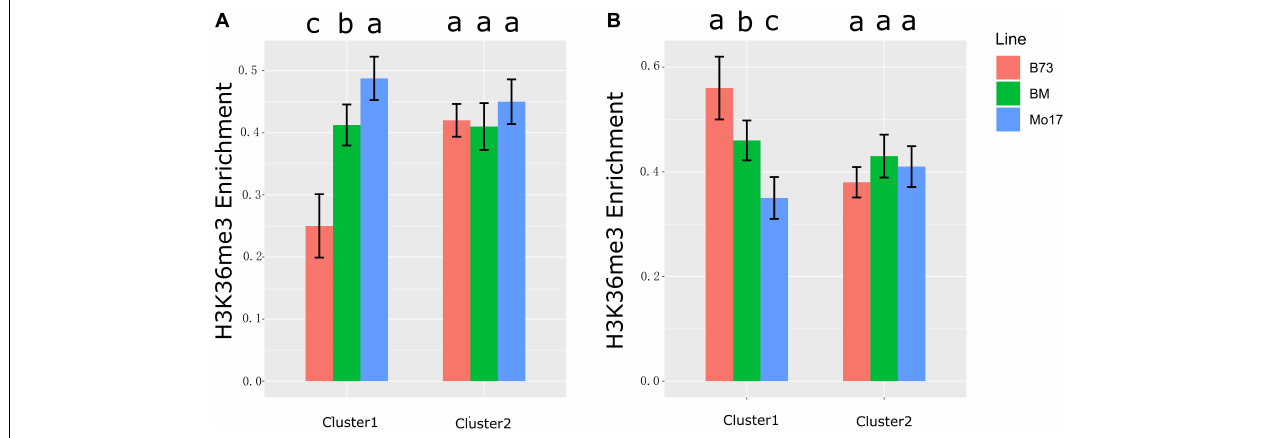
FIGURE 5 | H3K36me3 enrichment in gene body. (A) H3K36me3 enrichment of genes in cluster 1 and cluster 2 of Figure 4A (SPEA_B). (B) H3K36me3 enrichment of genes in cluster 1 and cluster 2 of Figure 4B (SPEA_M). The different colors of histogram represent three maize lines (B73, Mo17, and BM). The y -axis represents the normalized H3K36me3 signal of gene body (see section “Materials and Methods” for details). Different letters above the histogram indicate significant differences ( P < 0.05, Duncan multiple